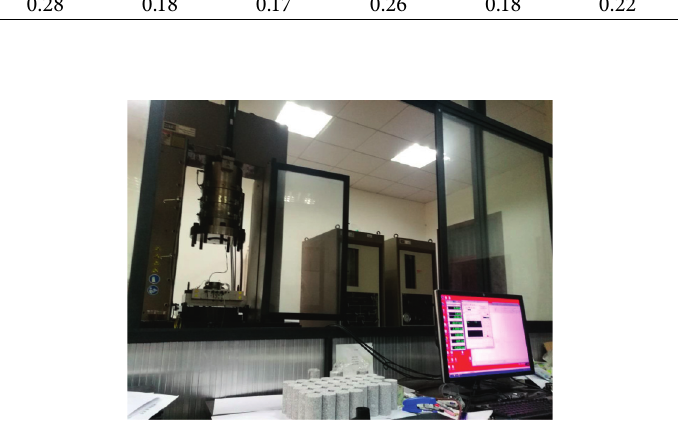
Figure 3: The MTS815 testing system. Table 2: Test stresses and hydraulic pressure